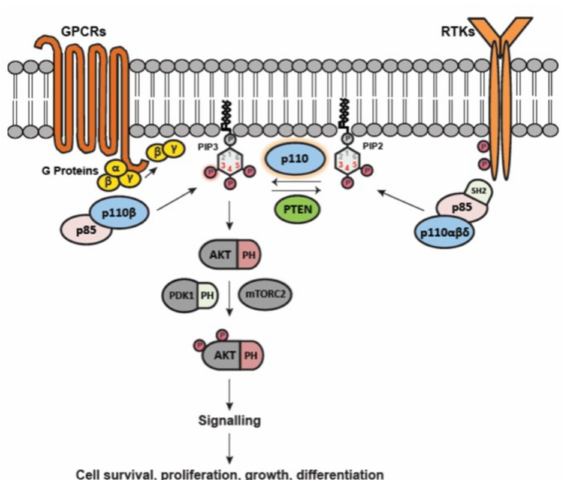
Figure 2. Class IA PI3K activation. Class IA PI3Ks consist of a catalytic subunit (p110) and a regulatory subunit (p85). Upon stimulation of receptor tyrosine kinase (RTK) or G-protein-coupled receptor (GPCR), the p85-p110 complex is targeted to the membrane via different mechanisms (due to tyrosine phosphorylation of RTKs or interaction with G-proteins β / γ ). The p85 subunit loses its inhibitory effect on the catalytic activity of p110, and thereafter the p110 subunit phosphorylates phosphatidylinositol (4,5)-bisphosphate (PIP2) to generate phosphatidylinositol (3,4,5)-triphosphate (PIP3). PIP3 then targets proteins containing the pleckstrin homology (PH) domain—such as AKT, phosphoinositide-dependent kinase 1 (PDK1), as well as Sin1 (not shown), part of the mammalian target of rapamycin complex 2 (mTORC2) and locates them to the plasma membrane. AKT is then phosphorylated on Thr308 and Ser473 by PDK1 and mTORC2 respectively. Once these proteins are activated at the membrane, they trigger a signalling cascade that leads to multiple cellular functions. Phosphate groups are indicated with a circled